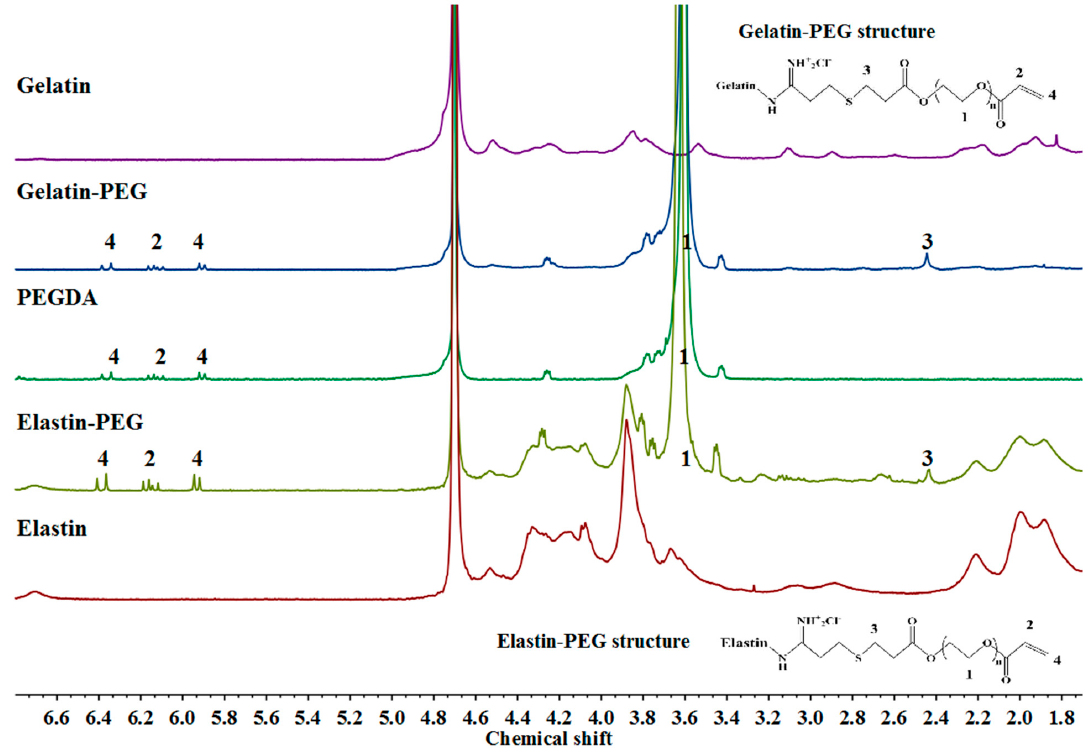
Figure 2. 1 H Nuclear magnetic resonance (NMR) spectra of gelatin, elastin, PEGDA, gelatin–PEG–acrylate, and elastin–PEG–acrylate. Table 2. The constitution of gelatin–PEG and elastin–PEG precursor. The concentration of gelatin and elastin in precursor were measured by BCA method. The conjugation efficiency of amine groups and PEGDA was determined by trinitrobenzenesulfonic acid assay (TNBSA) method. (Mean ± STDEV, n=3, p<0.05).